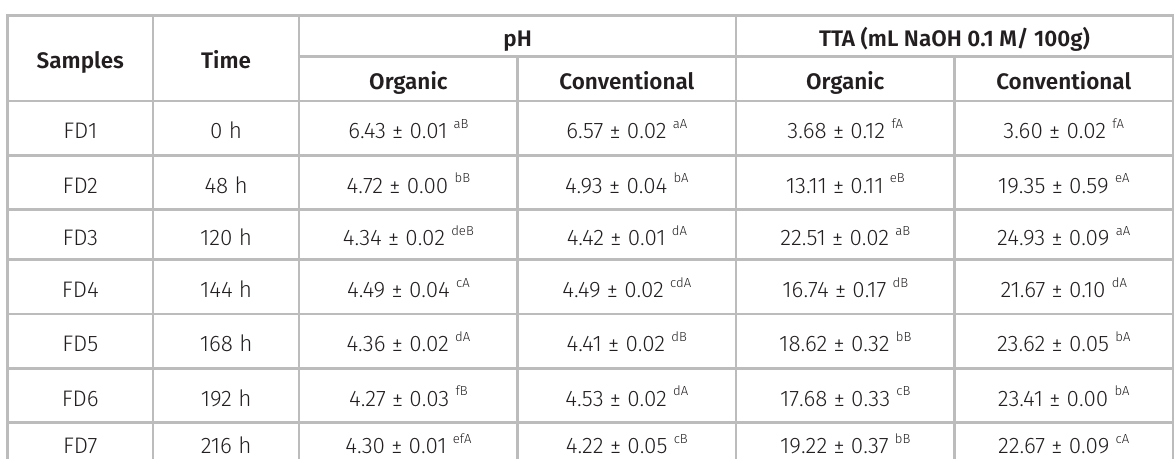
Table I. The pH and total titratable acidity (TTA) values on fermented doughs prepared with organic or conventional whole wheat